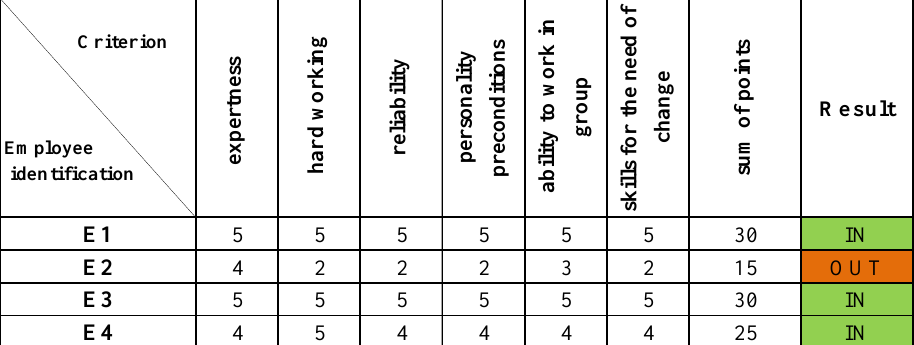
Table 5 – Evaluation of criteria by Head of dispatch department